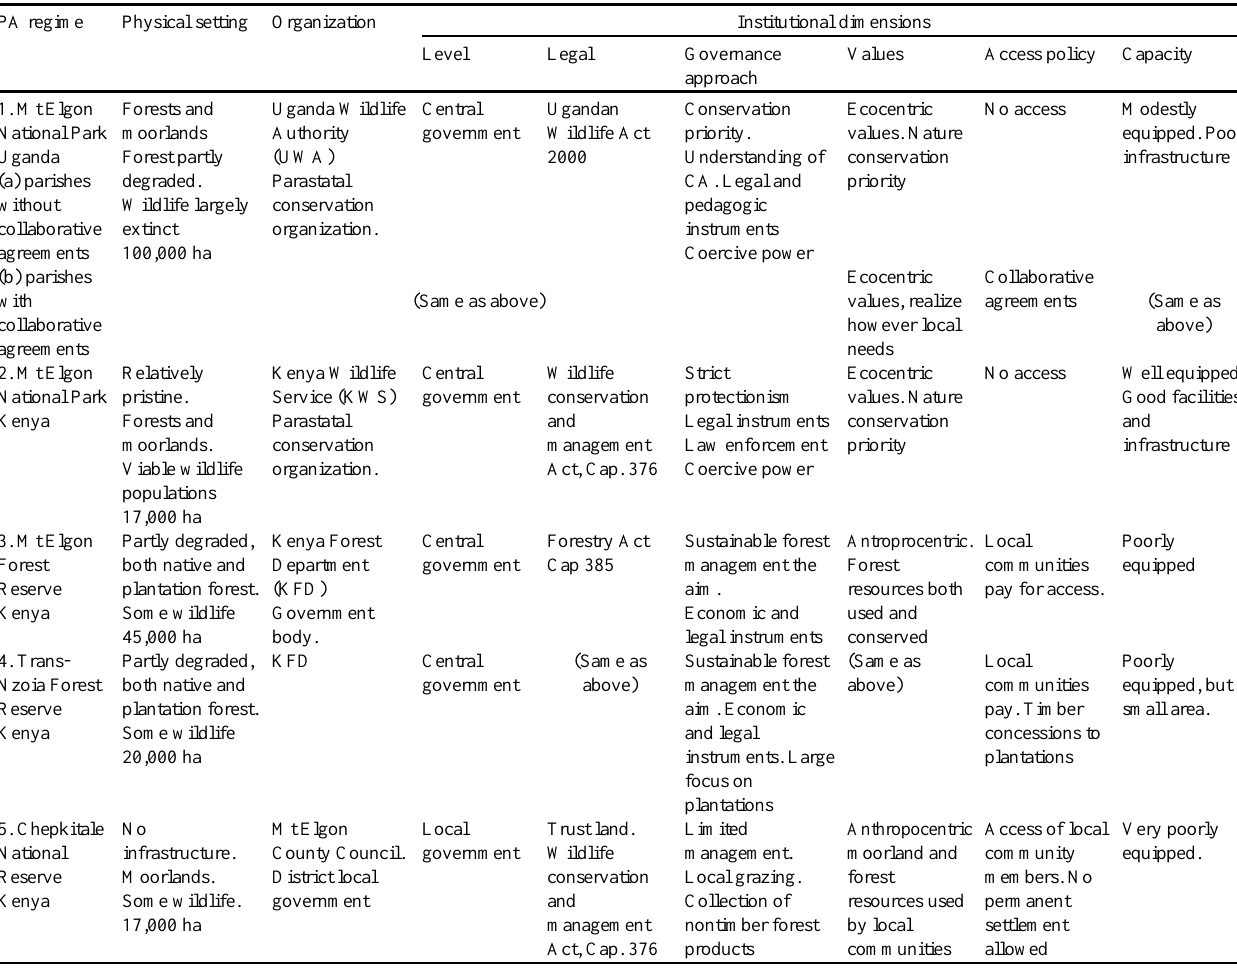
Table 3 . The protected areas (PA) resource regimes operating on Mt